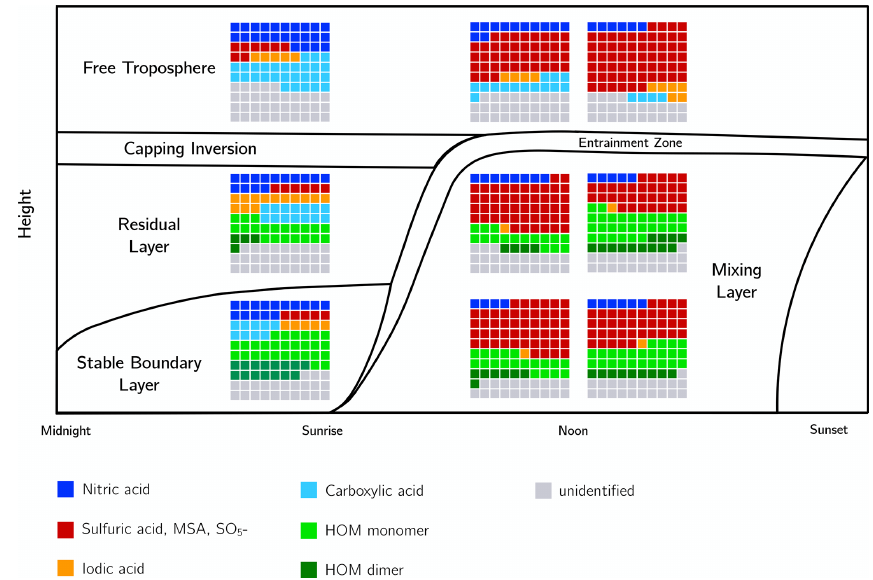
Figure 19. Schematic of ions observed within the boundary layer and free troposphere. The waffle plots show the fraction of different compounds, such as nitric acid (dark blue); sulfuric acid, MSA, and SO − (red); iodic acid (yellow); carboxylic acid (cyan); and HOM 5 monomer (light green); and dimer (dark green). All unidentified ions are shown in grey. In total, each “waffle” contains 100 squares; therefore each square represents 1% of the total signal. The fractions of the compounds are the median of all measurements in the corresponding layers. The mixing layer was measured twice, before noon and in the afternoon. The two levels shown in the schematic are at 100 and